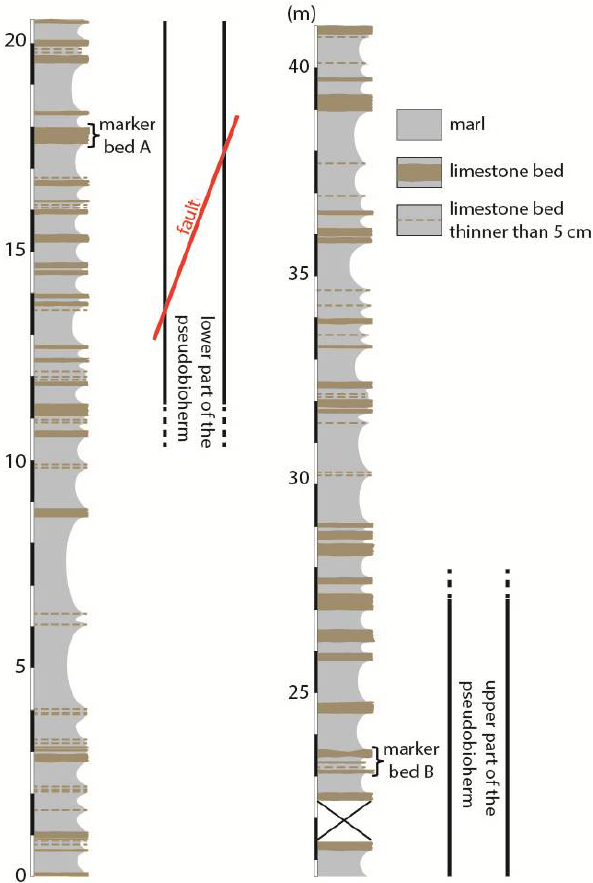
Figure 2. Lithologic log of the middle-Callovian deposits in the pseudobioherm-bearing interval, logged about 20m to the west of the upper part of the pseudobioherm, not affected by faulting; note marker beds A and B, which are easily recognizable in both host sediment and